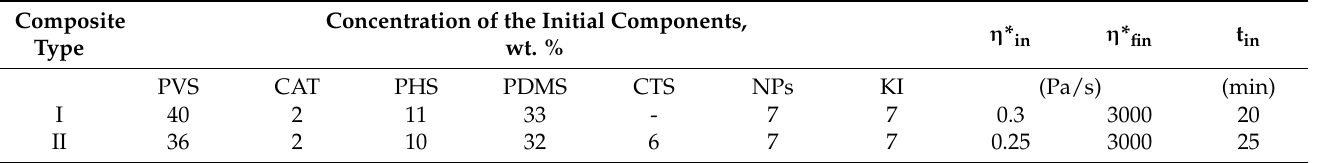
Table 3. Nanoembosile ® composition.